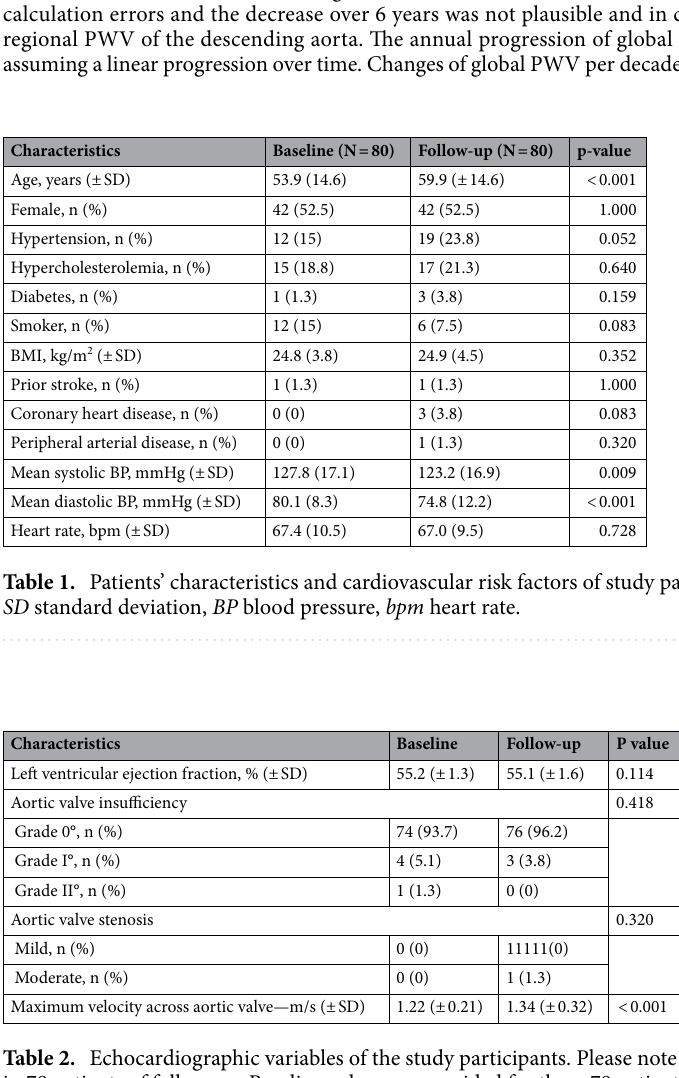
Table 2. Echocardiographic variables of the study participants. Please note that TTE information was available in 79 patients of follow-up. Baseline values are provided for these 79 patients. At follow-up, maximum velocity across aortic valve were available in 78 of 80 patients. We detected no bicuspid aortic valve in our patients. N = number of subjects, SD = standard deviation.